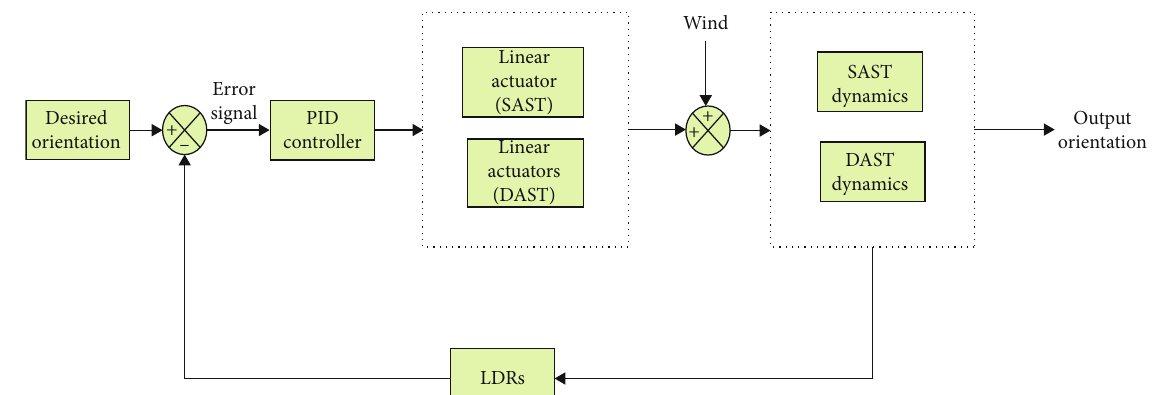
Figure 4: Block diagram of the close-loop feedback